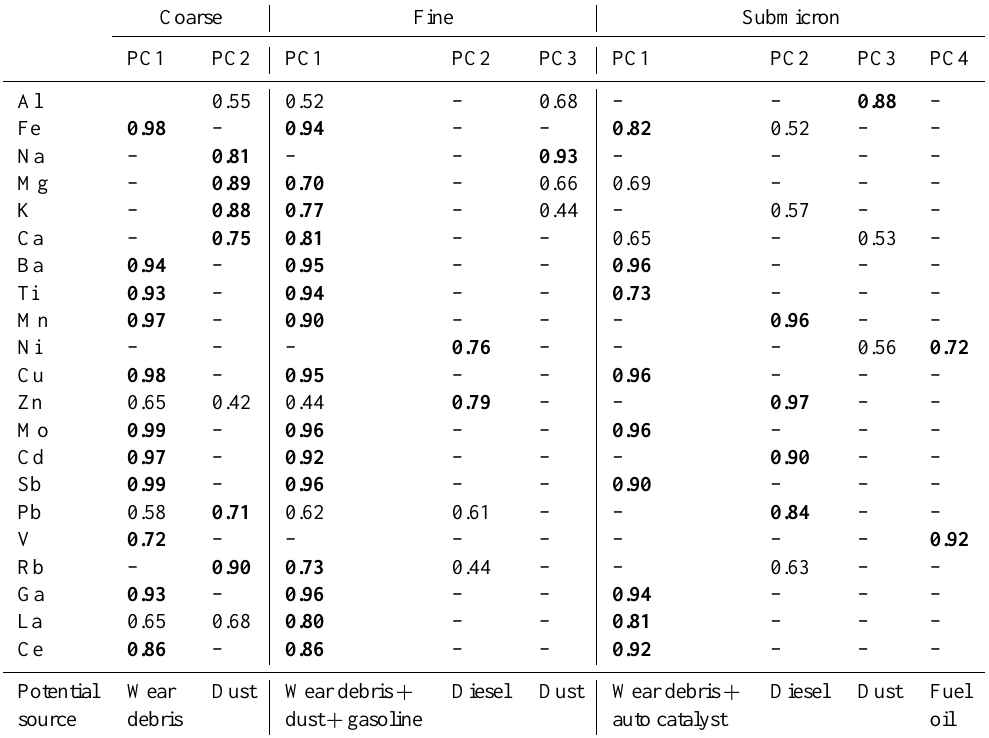
Table 3. Summaries of principal component analysis for trace metals in coarse, fine and submicron particles observed in Hsuehshan Tunnel. Factor loadings lower than ± 0.4 are not given. Factor loadings greater than 0.7 are marked in bold.